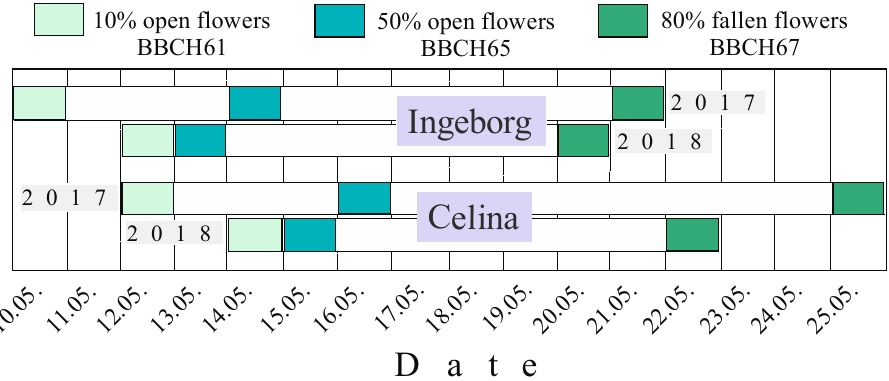
Figure 1. Flowering phenophases of pear cultivars ‘ Ingeborg ’ and ‘ Celina ’ in 2017 and 2018.